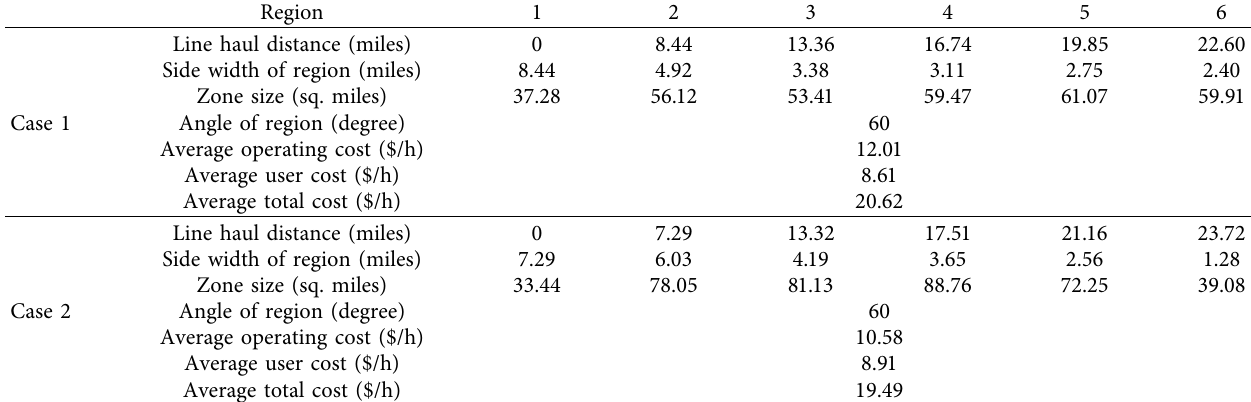
Table 2: Joint optimal solution in two